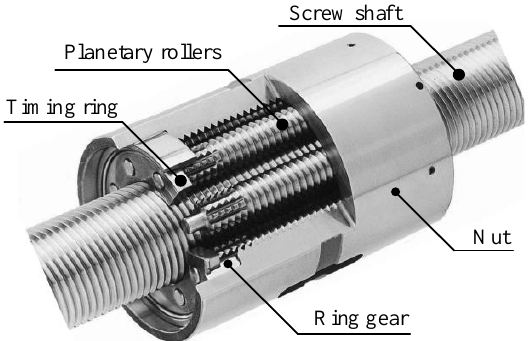
Figure 7: Planetary roller screw (PRS) main compo- nents. Image courtesy of Parker